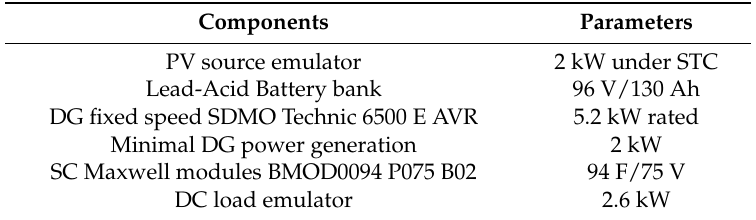
Table 1. Components for the microgrid system.